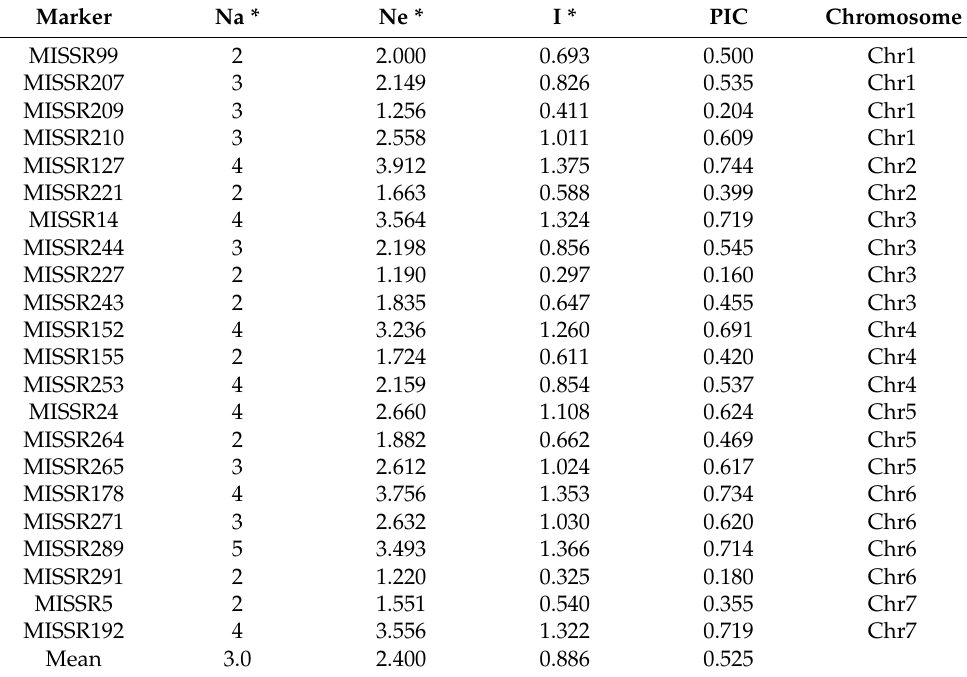
Table 4. The polymorphism information of